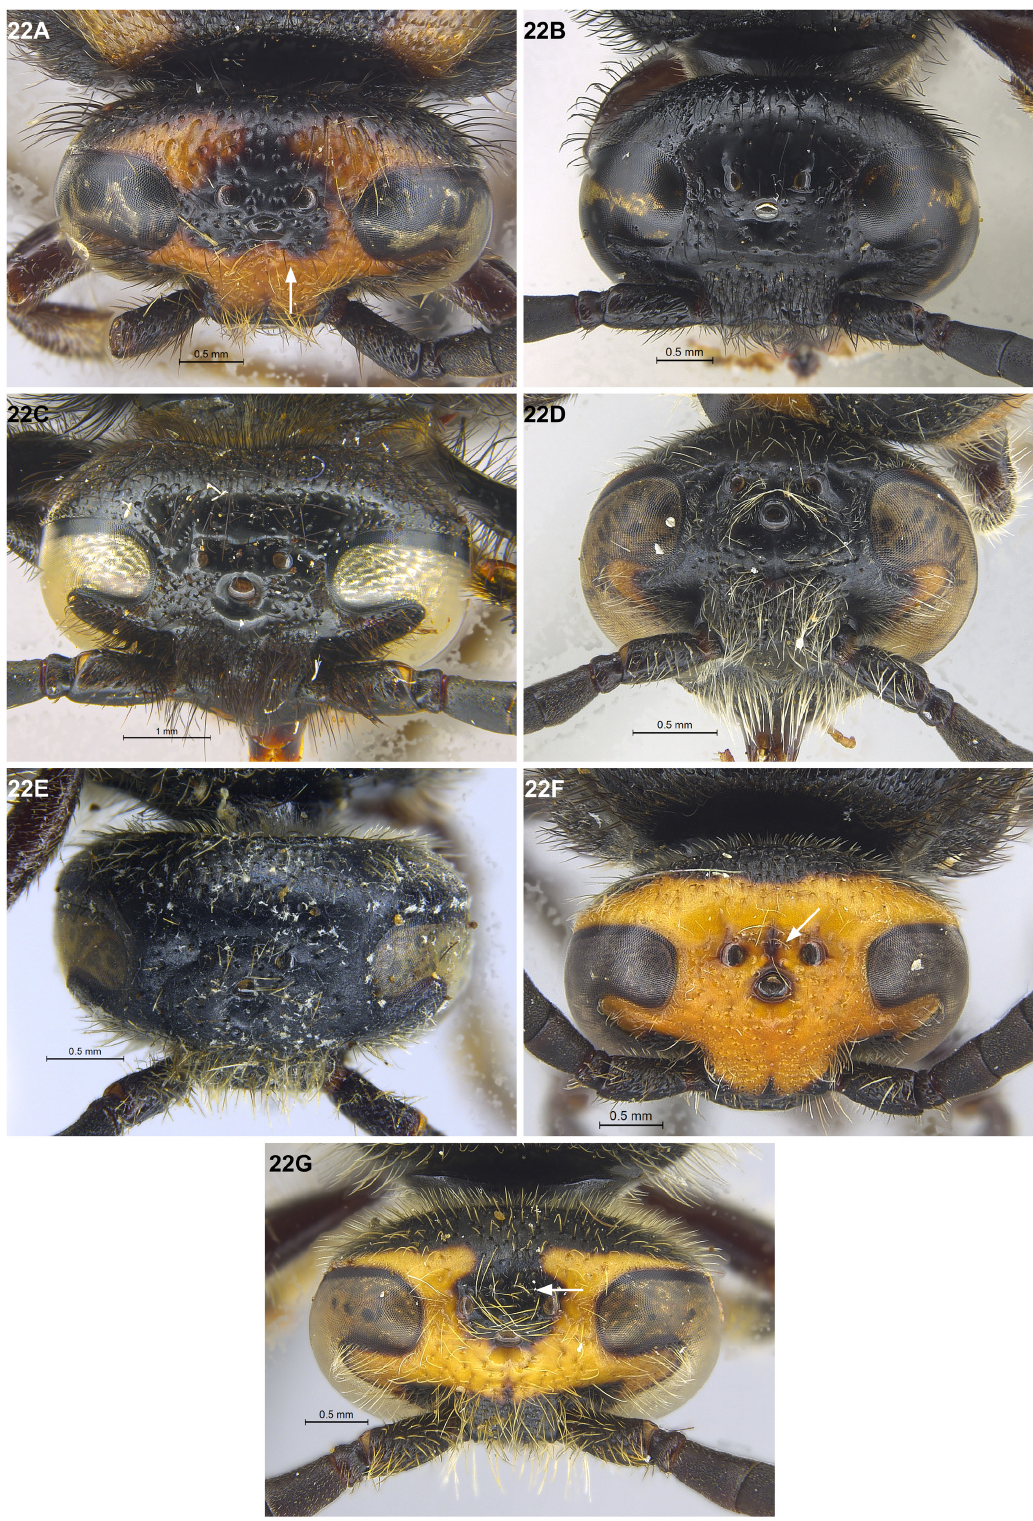
Fig. 22. Males, vertex. A . Carinoscolia junnanensis (Betrem, 1928). B . Liacos erythrosoma (Burmeister, 1854). C . Megascolia azurea (Christ, 1791). D . Scolia binotata Fabricius, 1804. E . Sc. laeviceps Smith, 1855. F . Sc. pakshaoensis sp. nov., paratype (CBC). G . Sc . superciliaris de Saussure & Sichel, 1864